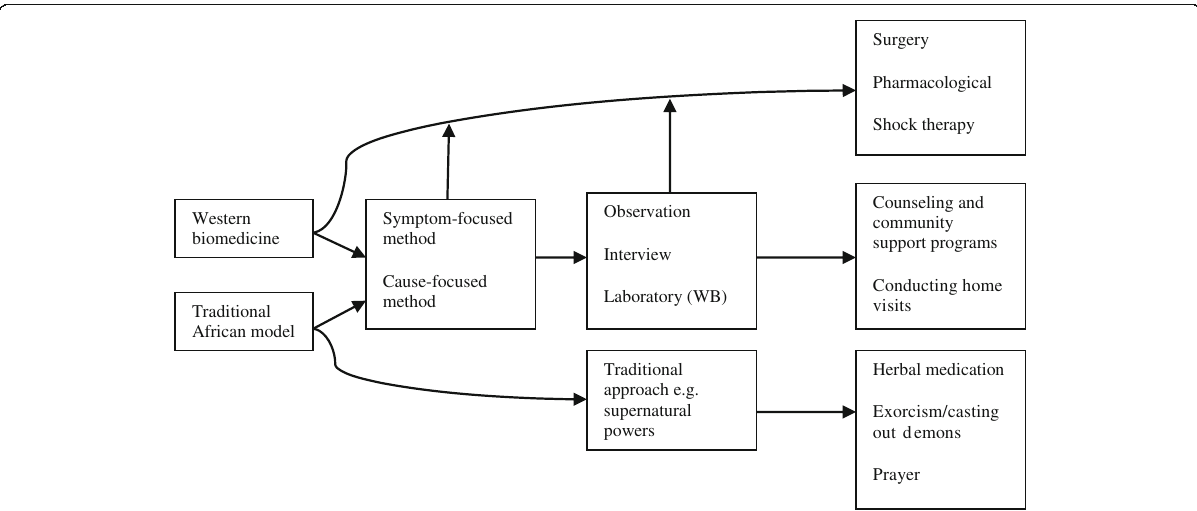
Fig. 1 Relationship between Western biomedicine and Traditional African Model. Both Western Biomedicine (WB) and Traditional African Model (TAM) use similar methods to identify the cause of mental illness and to provide treatments for mental illness. The specific treatment modalities include herbal medication, casting out demons and prayer for TAM; and surgery, pharmacological and shock therapy for WB. In some instances a verbal (undocumented) referral for laboratory testing is made if during TAM the practitioner realizes this need. Traditional approaches such